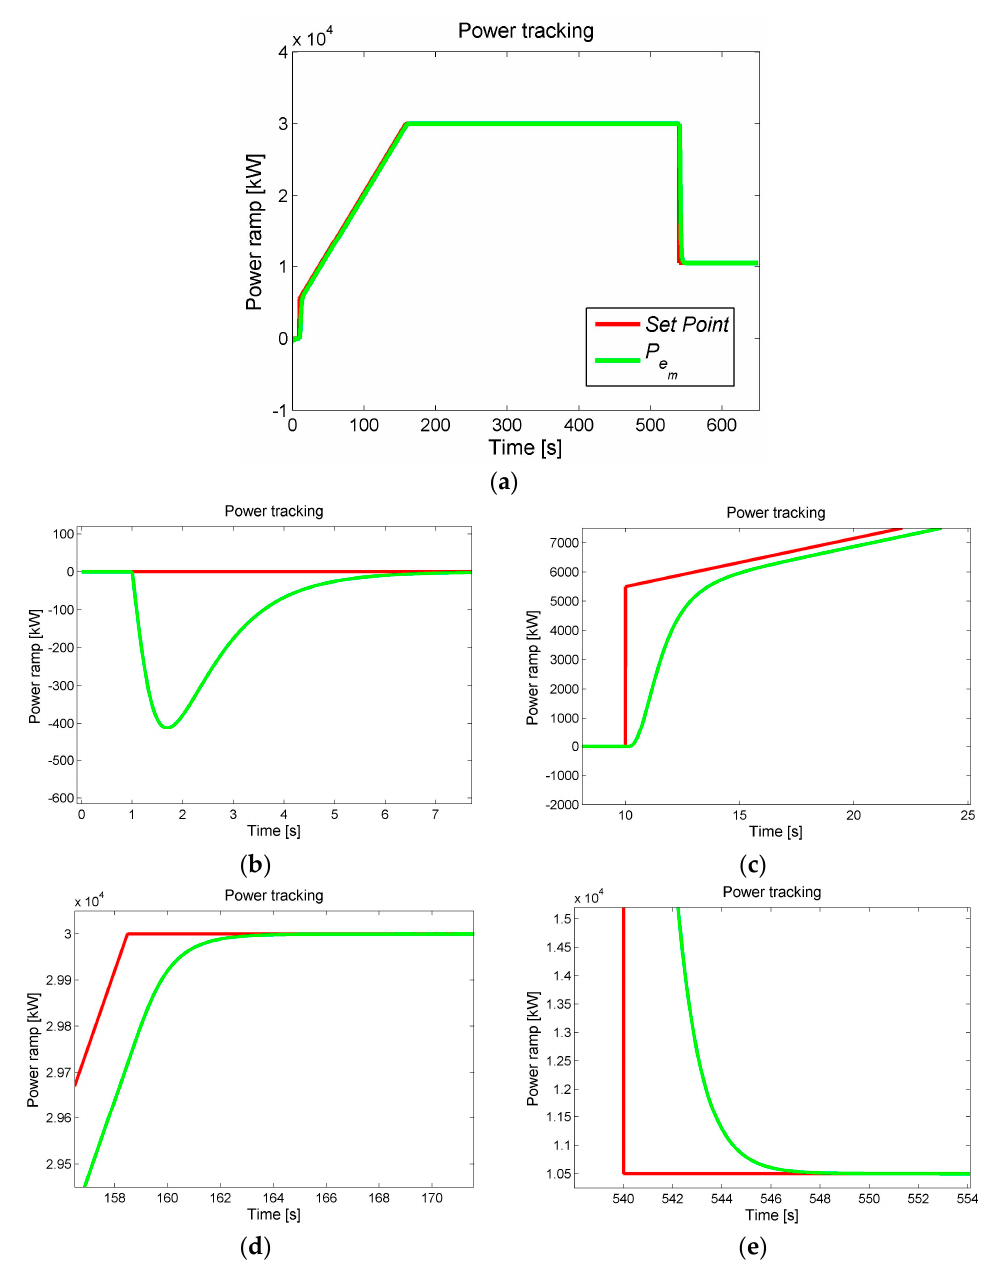
Figure 15. Closed-loop power reference tracking of the nominal system: ( a ) Complete view; ( b ) Disturbance rejection in the initial stage; ( c ) Ramp command start ; ( d ) Steady-state at 30 MW; ( e ) Power profile in the final stage.